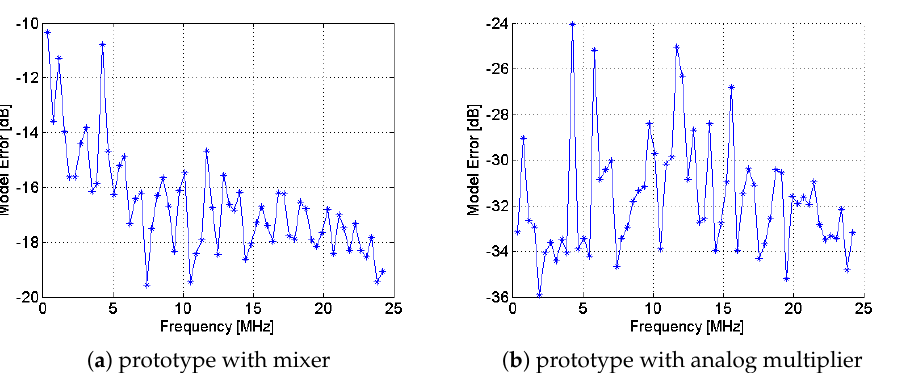
Figure 5. Experimental results of ME in the RD based on ( a ) the mixer and ( b ) the analog multi- plier